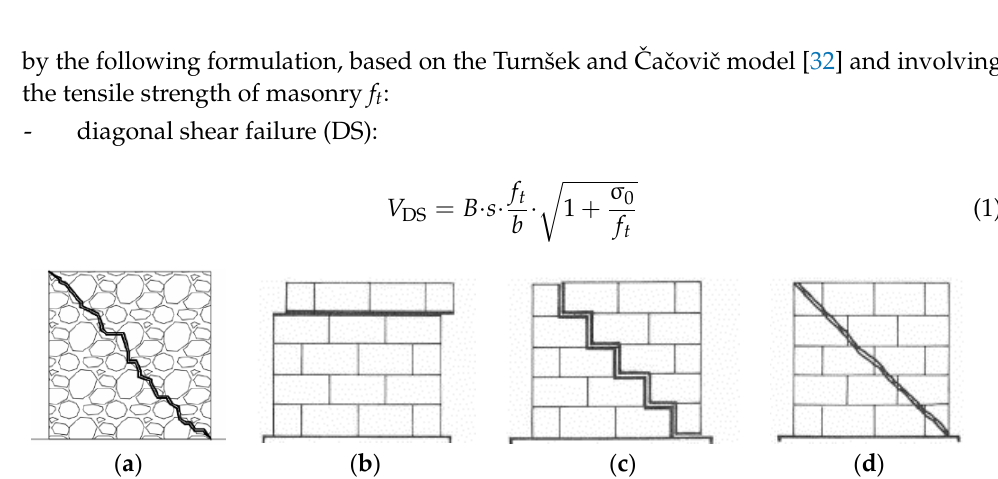
Figure 1 . Different shear mechanisms in masonry walls: ( a ) diagonal shear failure (DS) in irregular masonry; ( b ) horizontal sliding shear failure (HSS) in regular masonry; ( c ) diagonal sliding shear failure (DSS) in regular masonry; ( d ) tensile diagonal cracking in the units (TDC) in regular masonry. Reprinted from Ref. [11].